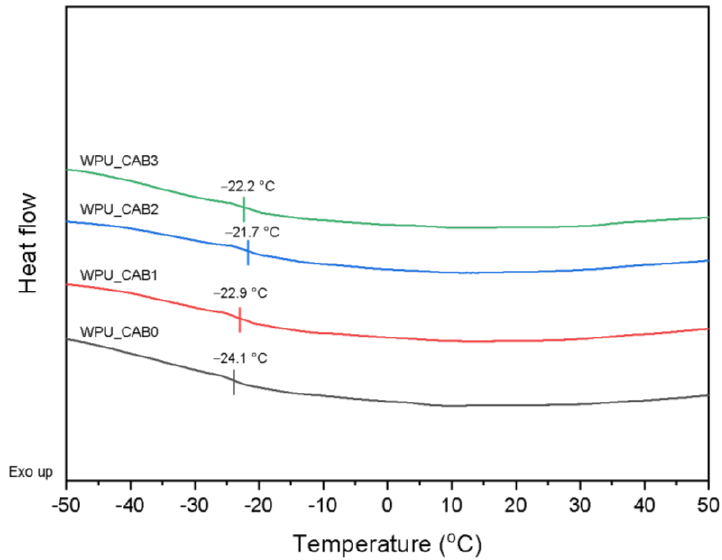
Figure 4. DSC thermograms of WPU films with different CAB contents.